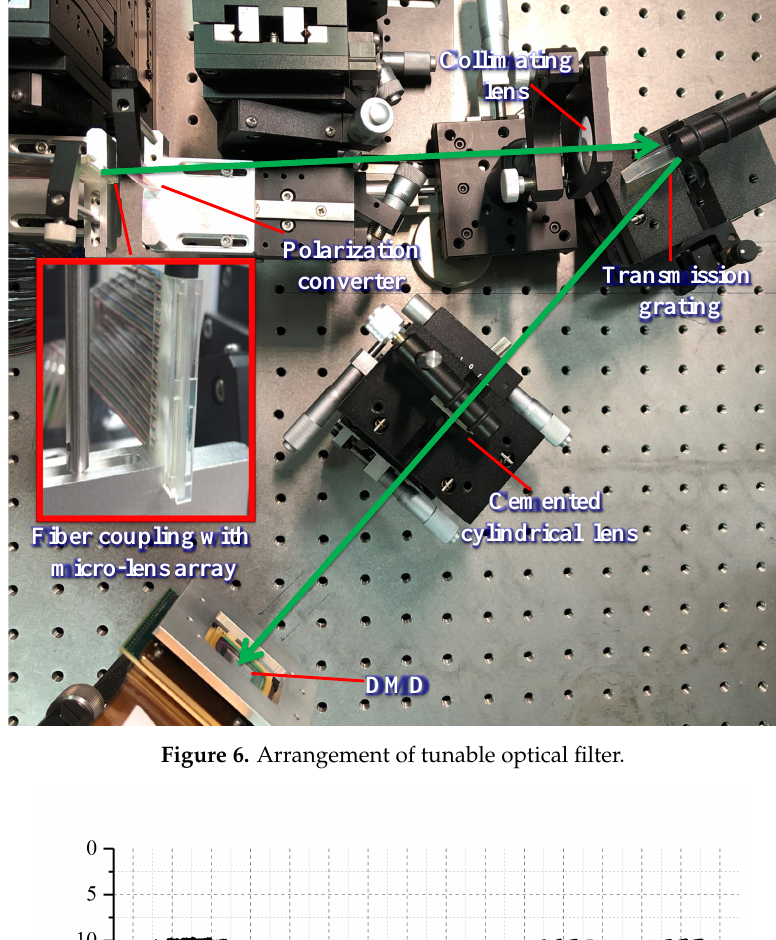
Figure 6. Arrangement of tunable optical filter.